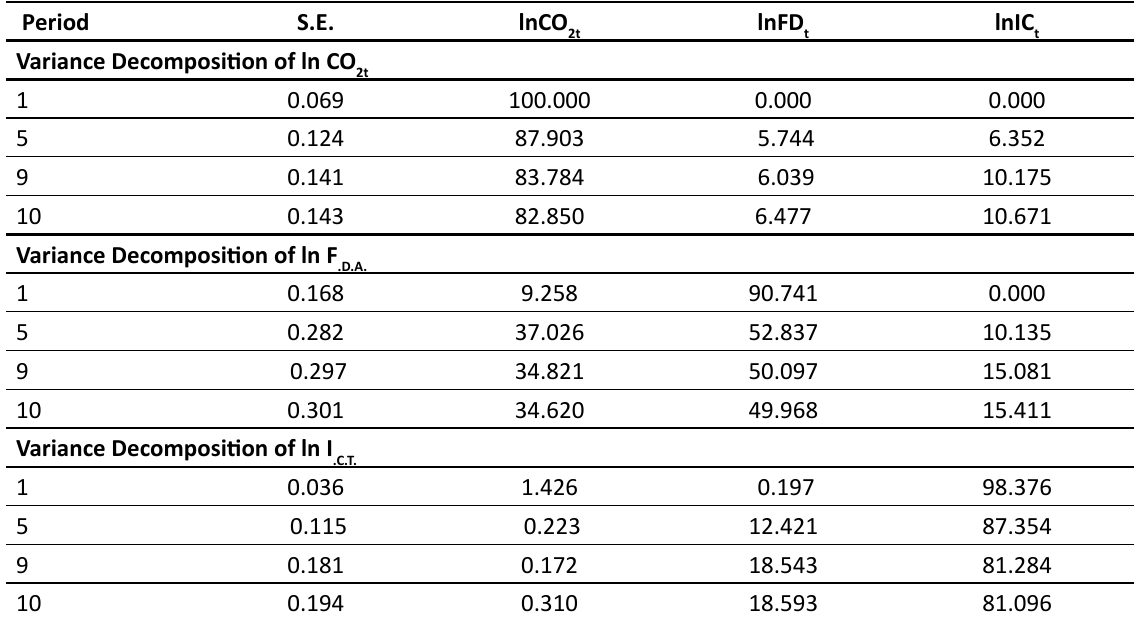
Table 10: Variance Decomposition Analysis Result